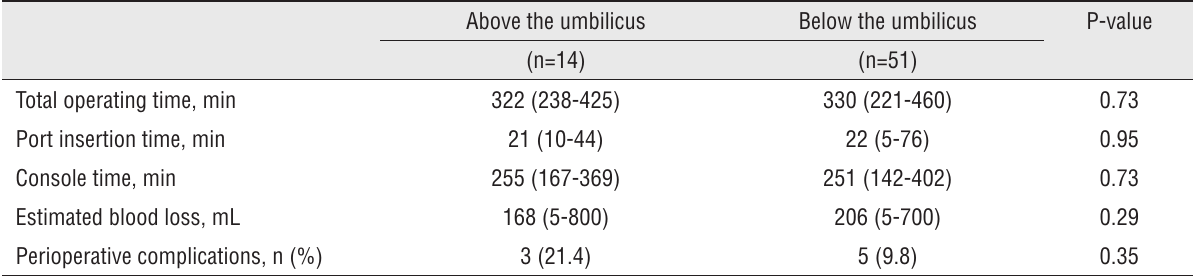
Table 4 - Comparison of patients with prior surgery below or above the umbilicus.